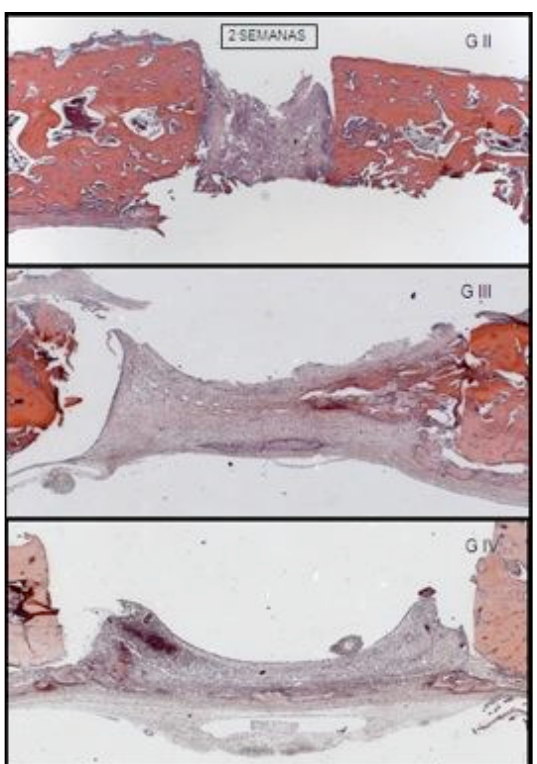
FIGURE 6 - Histological slides of the skull at M3 in Groups II, III and IV after 2 weeks